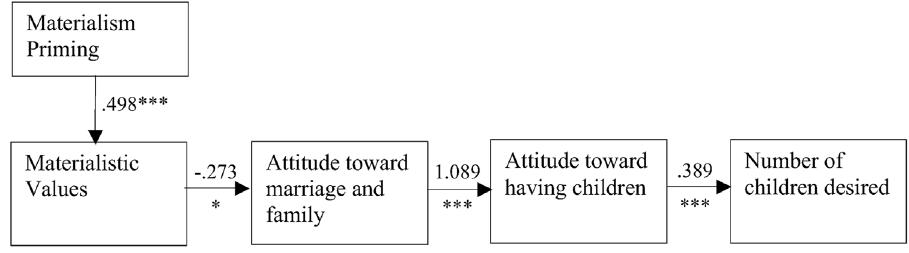
Fig 2. The Modified Incompatibility of Materialism and Children Model. χ 2 (6) = 5.00, p = .54, CFI = 1.00, RMSEA = 0.00, -0.178 < CI < -0.001 (for indirect effect from Materialism Priming to Number of children desired). Note: * p < .05, *** p <